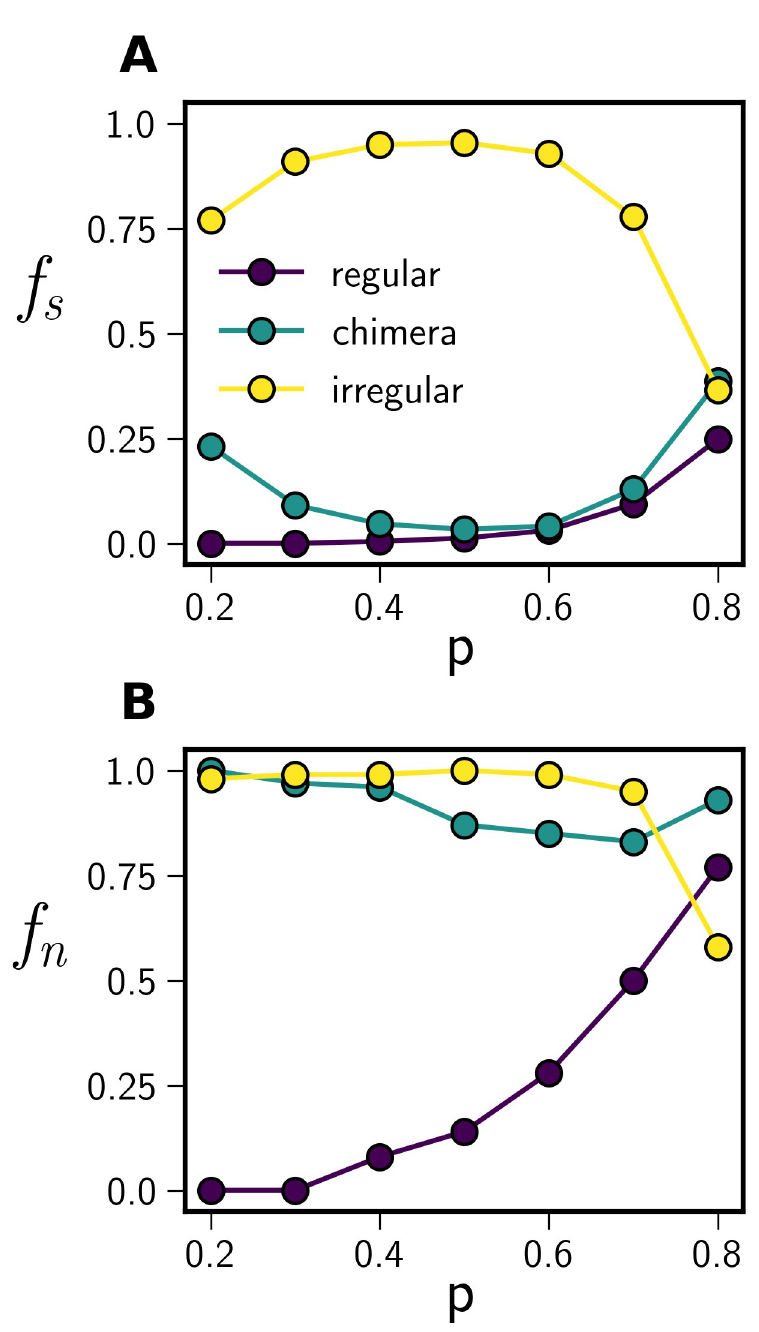
Fig 3. Effect of edge density on state frequencies. One-hundred networks with 500 different initial conditions each were generated with edge densities ( p ) between 0.2 and 0.8. The frequencies f s in A represent the fraction of all 50,000 network states generated at each p value that were classified as temporally-regular, chimeric, or temporally-irregular by ISI statistics. The frequencies f n in B are the fraction of 100 networks that produced at least one temporally-regular, chimera, or temporally-irregular state. Temporally-regular and temporally-irregular are abbreviated “regular” and “irregular,” respectively.